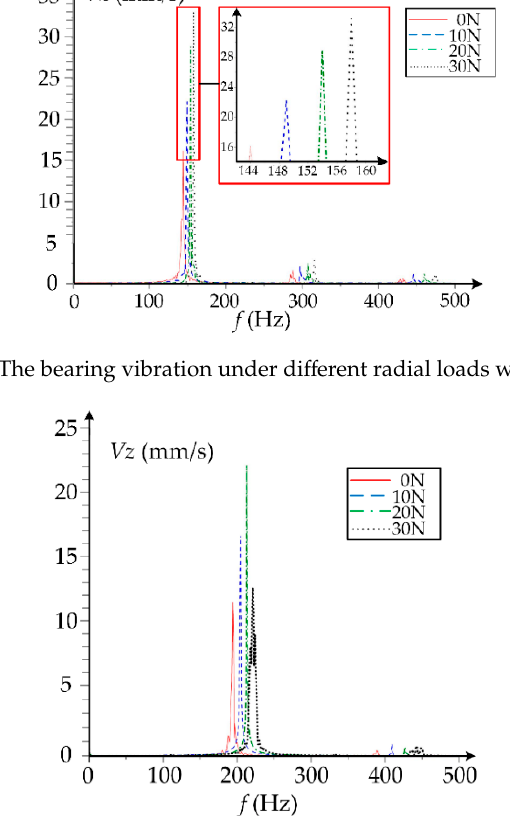
Figure 7. The bearing vibration under di ff erent radial loads when L =